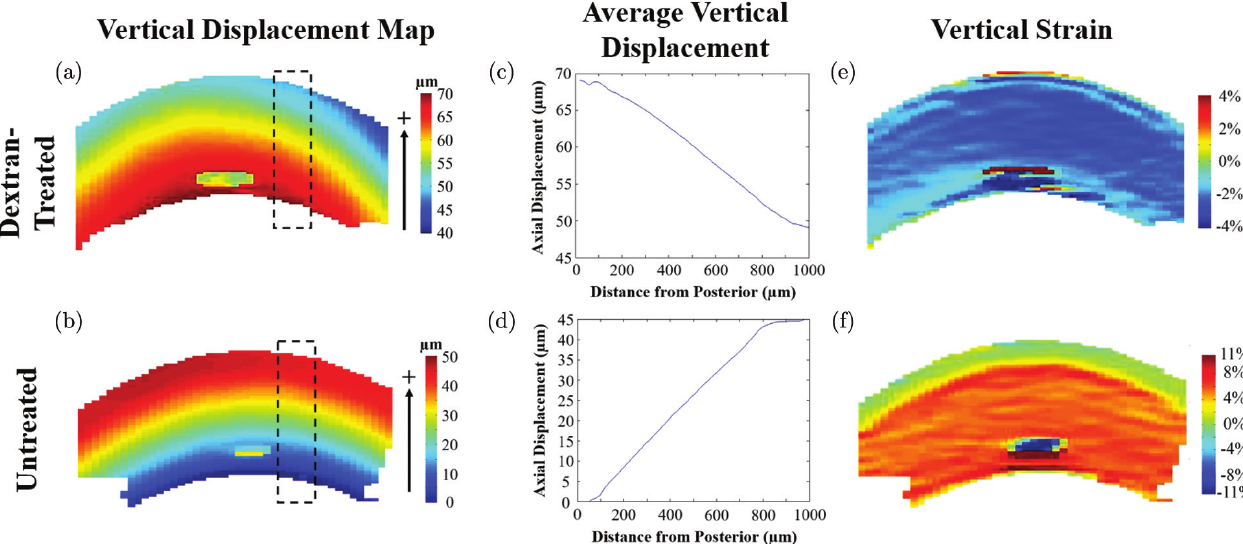
Fig. 2. (Color online) Vertical displacement (a, b) and vertical strain (e, f) plots of the central slice of representative corneas obtained in dextran-treated (a, c, e) or untreated (b, d, f) groups after in°ation from 10 mmHg to 12 mmHg. The average dis- placement at di®erent corneal depths (c, d) is obtained in the dashed regions of (a, b) and shows a constant displacement gradient that generates the horizontally homogenous vertical strain pro¯les in (e, f). Note that the irregular \spot" in the central posterior region of all images is caused by poor speckle tracking in the respective